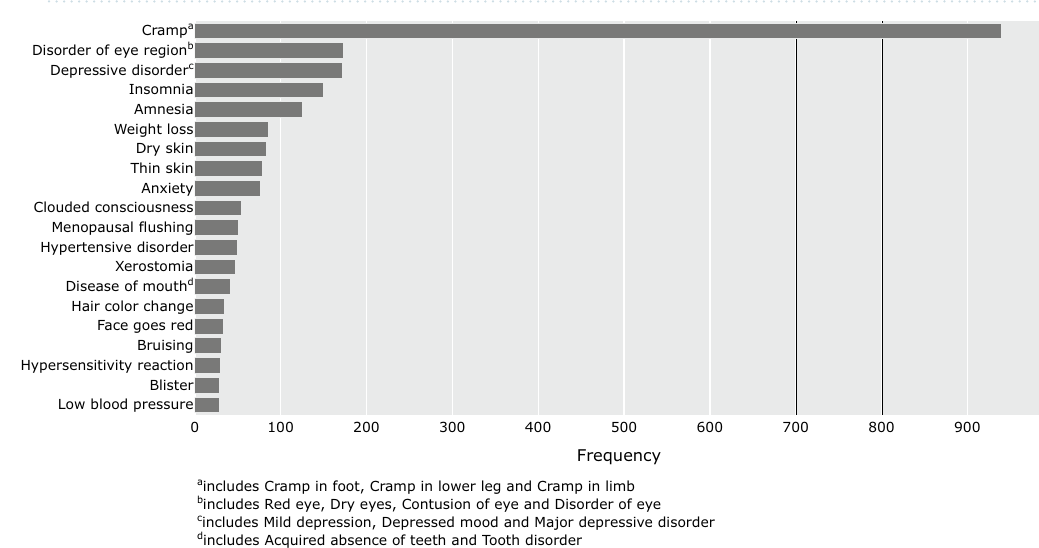
Figure 5. The 20 most prevalent adverse drug events for imatinib that were not found in the registration